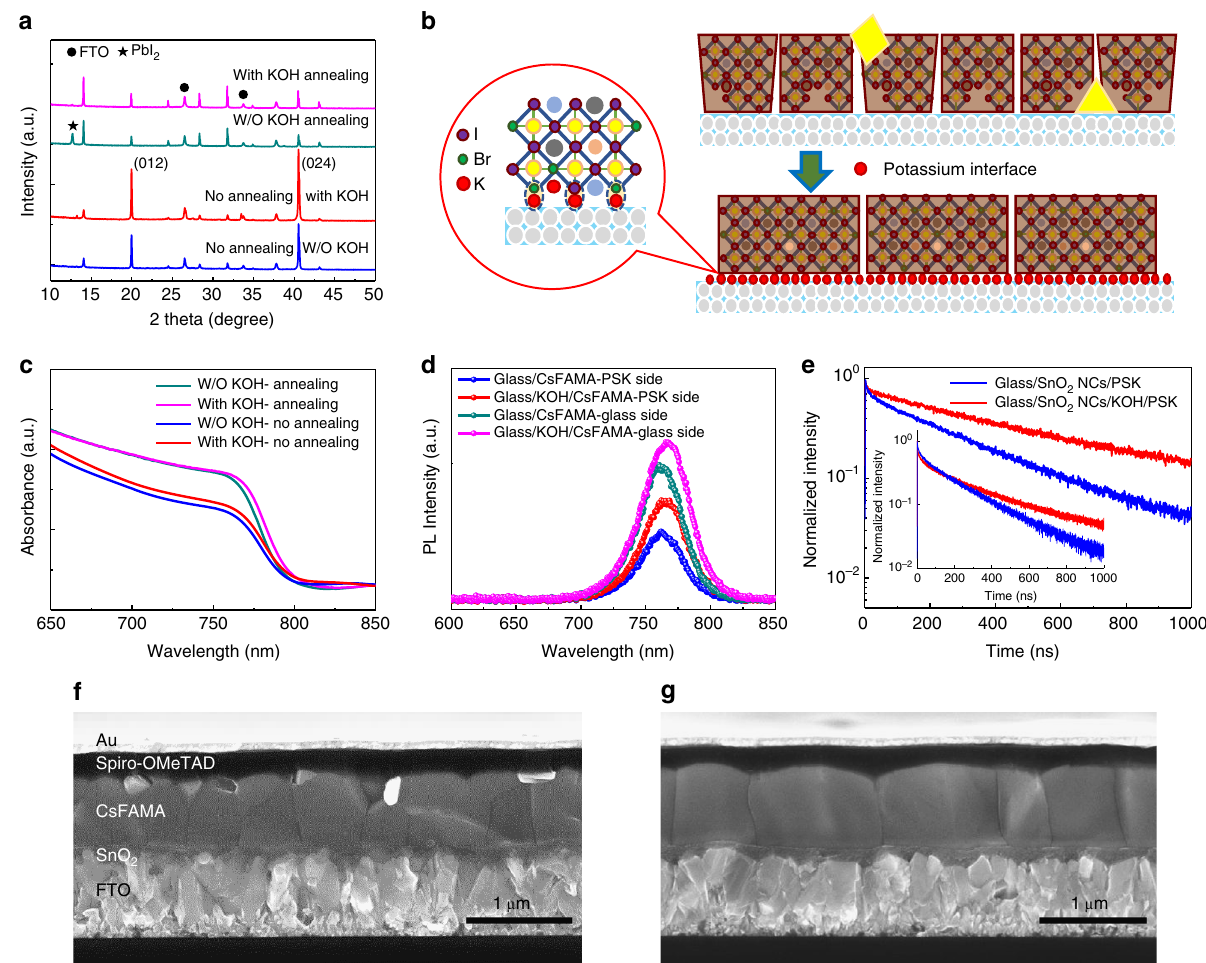
Fig. 4 Properties of perovskite fi lms with interface potassium passivation. a XRD patterns of different SnO 2 substrates-based perovskite fi lms with or without thermal annealing. b A schematic of the perovskite growth process on different substrates. c UV-Vis spectra of different SnO 2 substrates-based perovskite fi lms with/without thermal annealing. d The steady PL spectra of perovskites with/without interface potassium passivation. e The TRPL spectra of perovskites with and without interface potassium passivation. The inset plot shows the corresponding TRPL spectra when excitation laser is incident from the glass side. f Cross-section SEM image of the pristine perovskite device. g Cross-section SEM image of the perovskite device with